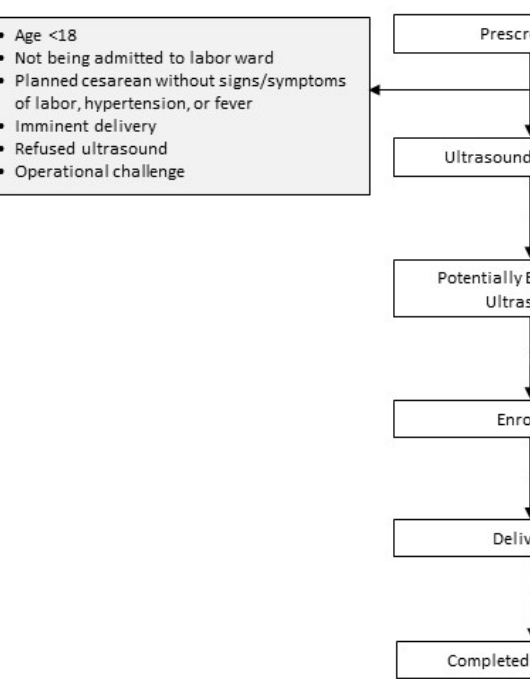
participants are informed about the study prior to presentation for labor and